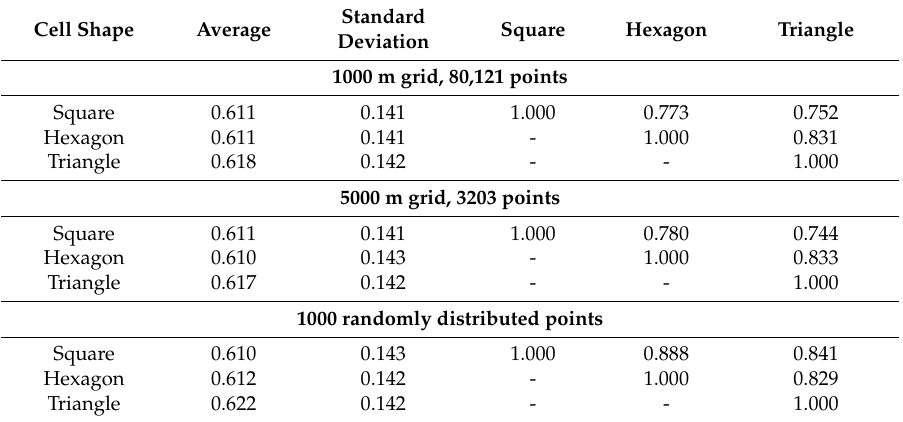
Table 5. Correlation matrix and basic statistic parameters.